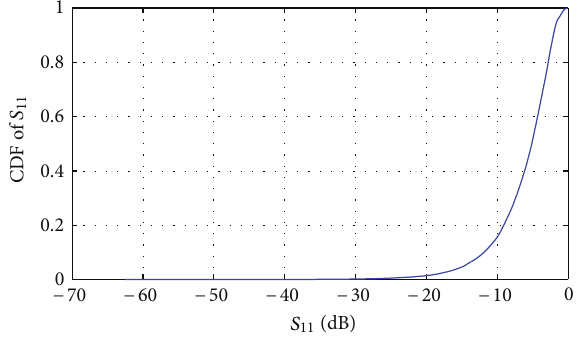
Figure 15: CDF of 𝑆 11 parameter.